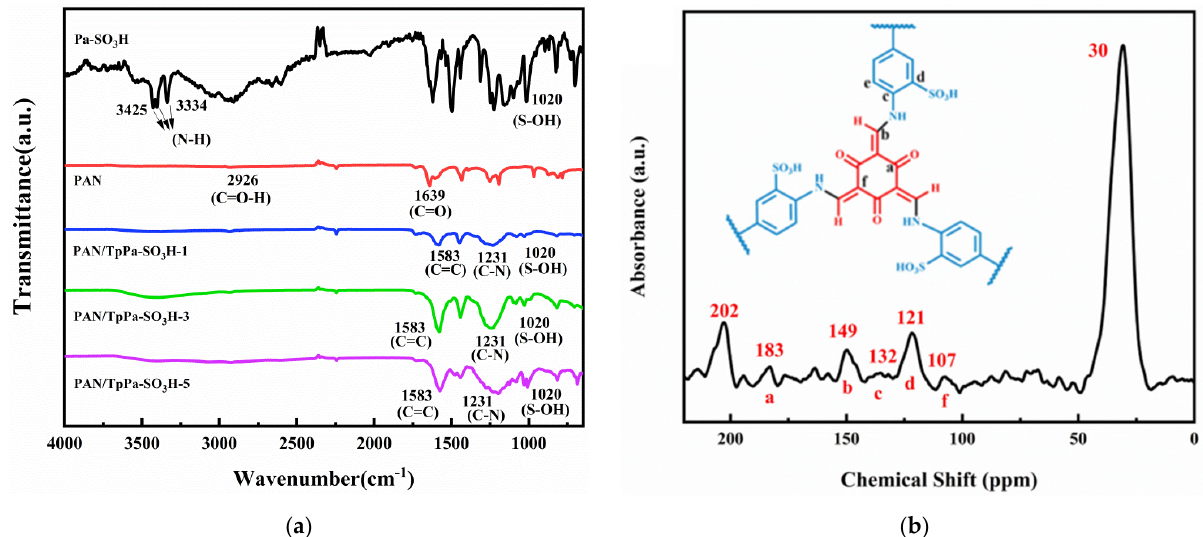
Figure 2. ( a ) FTIR image of Pa ‐ SO 3 H, PAN and PAN/TpPa ‐ SO 3 H with different ratio of Tp:PAN. ( b ) Solid state 13C CP ‐ MAS spectrum comparison of PAN/TpPa ‐ SO 3 H.